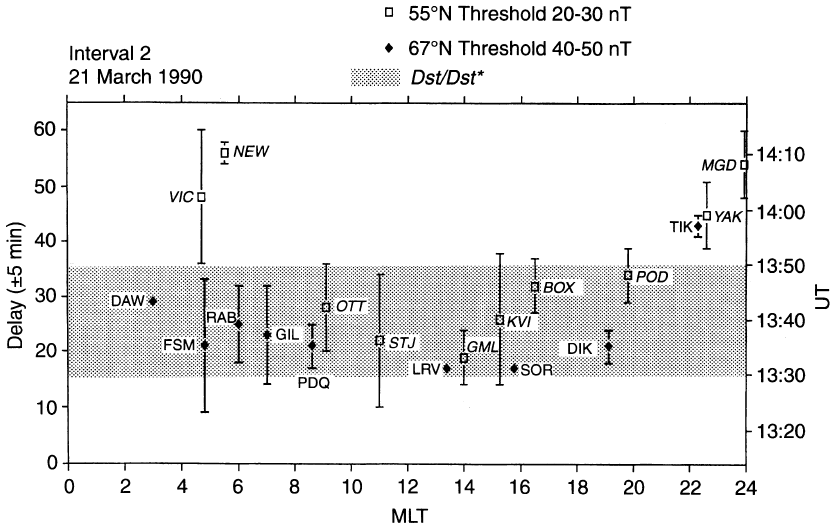
Fig. 7. Response times to the southward turning as a function of MLT at the subsolar magnetopause at 1314 UT on March 21 1990 during interval 2, with ground magnetometer responses at 55 (cid:176) N ( open square symbols ) and ground magnetometers at 67 (cid:176) N ( solid dia- mond symbols ). The shaded band represents the response time of Dst / Dst *. Note the (cid:139)5 min error on the delay axis which represents the uncertainties in the time at which the phase front of the southward turning was incident at the